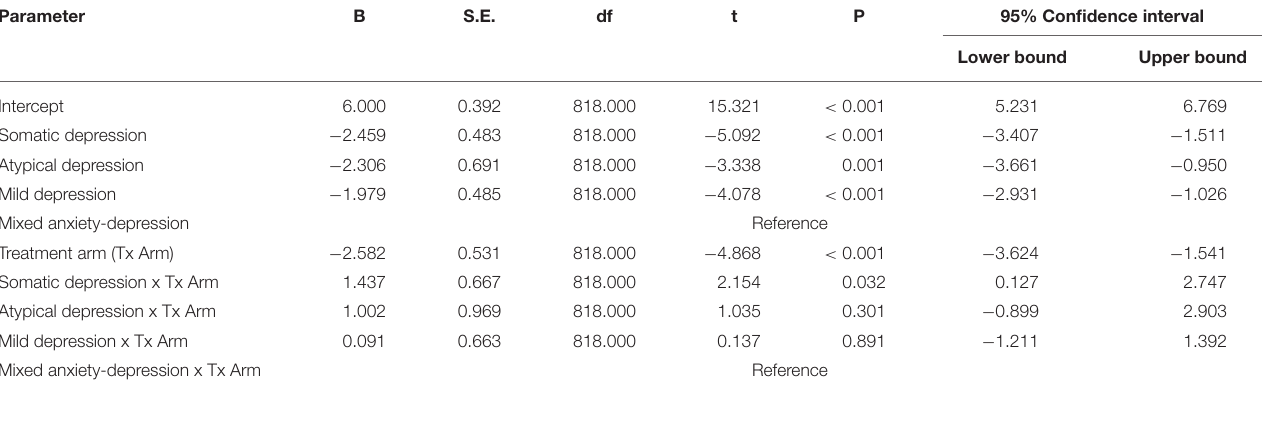
TABLE 4 | Linear fixed effects models for severity of disability.